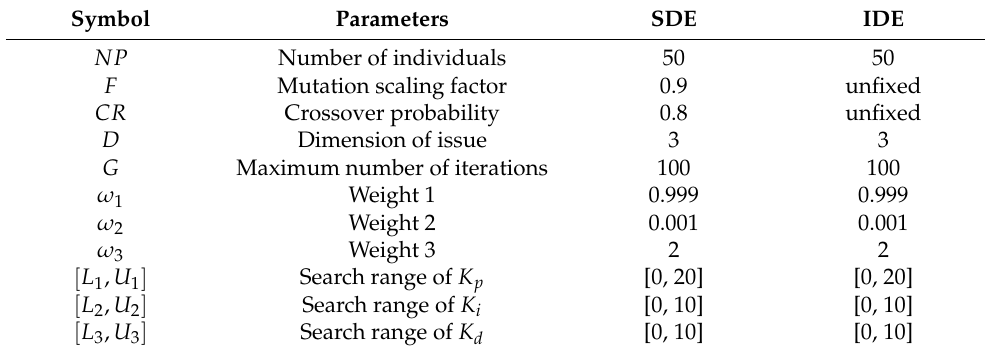
Table 1. Parameters of SDE and IDE tuning based on PID controller.